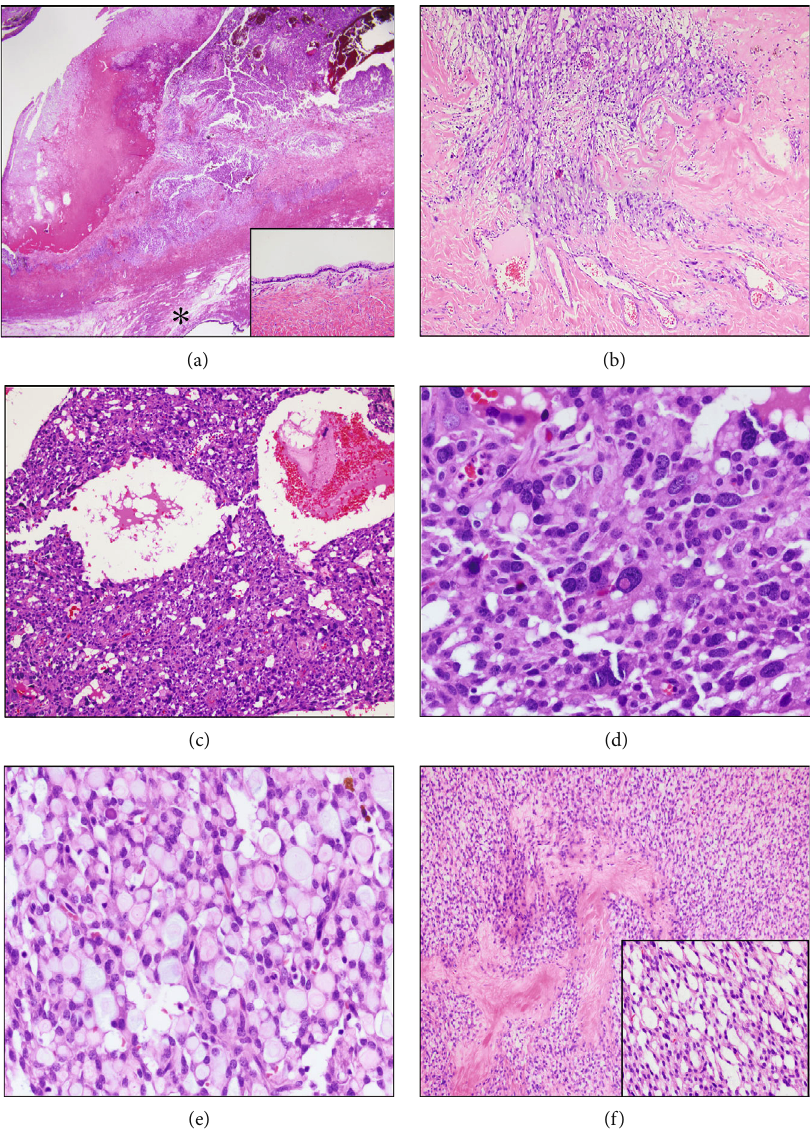
Figure 2: Microcystic stromal tumor (MST) of the ovary. (a) Solid nodule with in fi ltrative border, separate from a mucinous cyst (asterisk) by thick fi brous stroma (H&E, 1.25 × ). The cyst is lined with benign mucinous epithelium (inset) (H&E, 20 × ). (b) The irregular in fi ltrative- like border of MST (H&E, 10 × ). (c) Solid pattern with microcysts of variable caliber and the di ff use presence of bizarre cells. Large spaces containing blood and fi brin are also observed (H&E, 10 × ). (d) Bizarre cells with epithelioid features and pleomorphic hyperchromatic nuclei (H&E, 40 × ). (e) Aggregates of signet ring-like cells (H&E, 40 × ). (f) Typical MST features of cellular areas with hyalinized fi brous bands (H&E, 10 × ). Monotonous tumor cells with bland nuclei punctuated by relatively uniform microcystic spaces (inset) (H&E, 40 ×